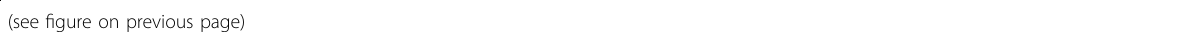
Fig. 6 Overexpression of BTF3b enhanced the sensitivity of prostate cancer cells to cisplatin in vitro and in vivo. a Cell viability was measured for BTF3b-overexpressing DU145 or control cells treated with or without cisplatin. Cells were exposed to drug treatment for 2 h and then subjected to fresh media for 3 days before MTT assay. Data are shown as mean ± S.D. for three independent experiments. ** p < 0.01 (Student ’ s t -test). b BTF3b-overexpressing DU145 or control cells were continuously treated with or without cisplatin (0.5 μ M) and then subjected to crystal violet assay. Representative images of the plates are shown. Quanti fi cation is shown as mean ± S.D. for three independent experiments. **** p < 0.0001 (Student ’ s t -test). c Immuno fl uorescent staining of cisplatin induced DNA-adducts (Red) and DAPI (Blue) in BTF3b-overexpressing DU145 or control cells. Cell were treated with cisplatin (50 μ M) for 2 h and cultured for 24 h. Representative images are shown. Quanti fi cation is shown as mean ± S.D. from three independent experiments. Scale bar, 100 μ m. n.s., not signi fi cant, **** p < 0.0001 (Student ’ s t -test). d Comet assay was performed to evaluate DNA damage in cells as in c treated with or without cisplatin at indicated concentration for 1 h. Quanti fi cation of DNA in the tail from three independent experiments is shown as mean ± S.D. Scale bar, 100 μ m. Data are shown as mean ± S.D. for three independent experiments. *** p < 0.001, **** p < 0.0001 (Student ’ s t -test). e The tumor growth curve of DU145 xenografts expressing BTF3b or control vector treated with cisplatin (5 mg/kg) or vehicle. The arrows indicate the treatment time points. f Representative images showed dissected tumors in different treatment groups as indicated at the endpoint. The data are shown as mean ± S.E.M. n = 6 for each group. n.s., not signi fi cant, *** p < 0.001, **** p < 0.0001 (one-way ANOVA, with Tukey ’ s multiple comparison